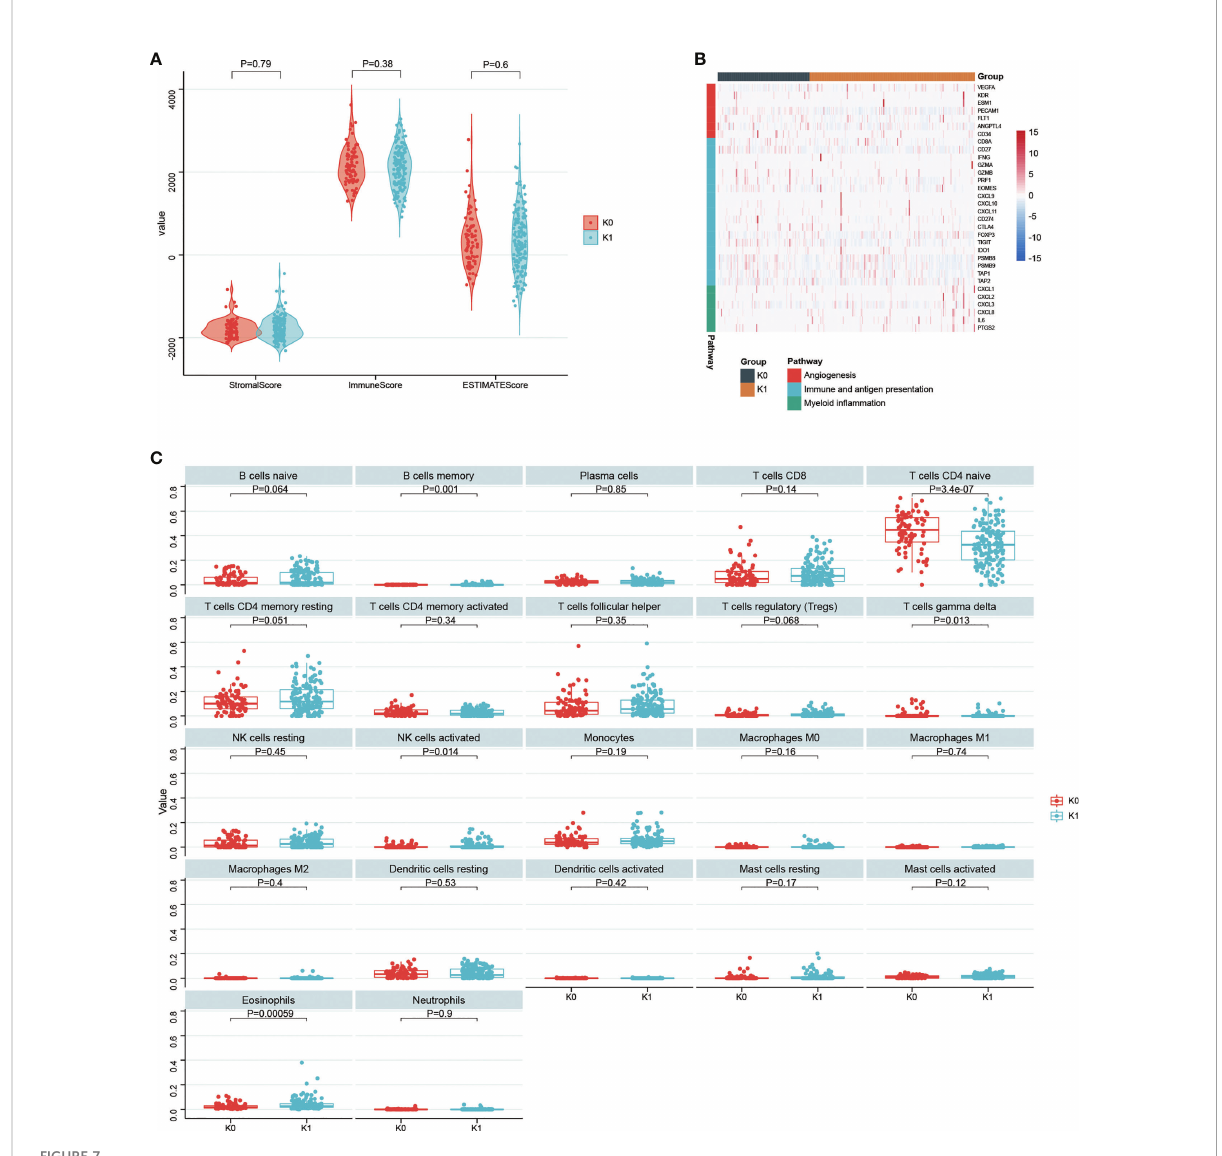
FIGURE 7 (A) Statistical comparison of StromalScore, ImmuneScore and ESTIMATEScore between K0 and K1 subgroups. (B) Gene expression in tumor microenvironmental pathways associated with immune and antigen presentation, angiogenesis, and myeloid in fl ammation. (C) 22 in fi ltrated immune cells between the K0 and K1 subgroups were